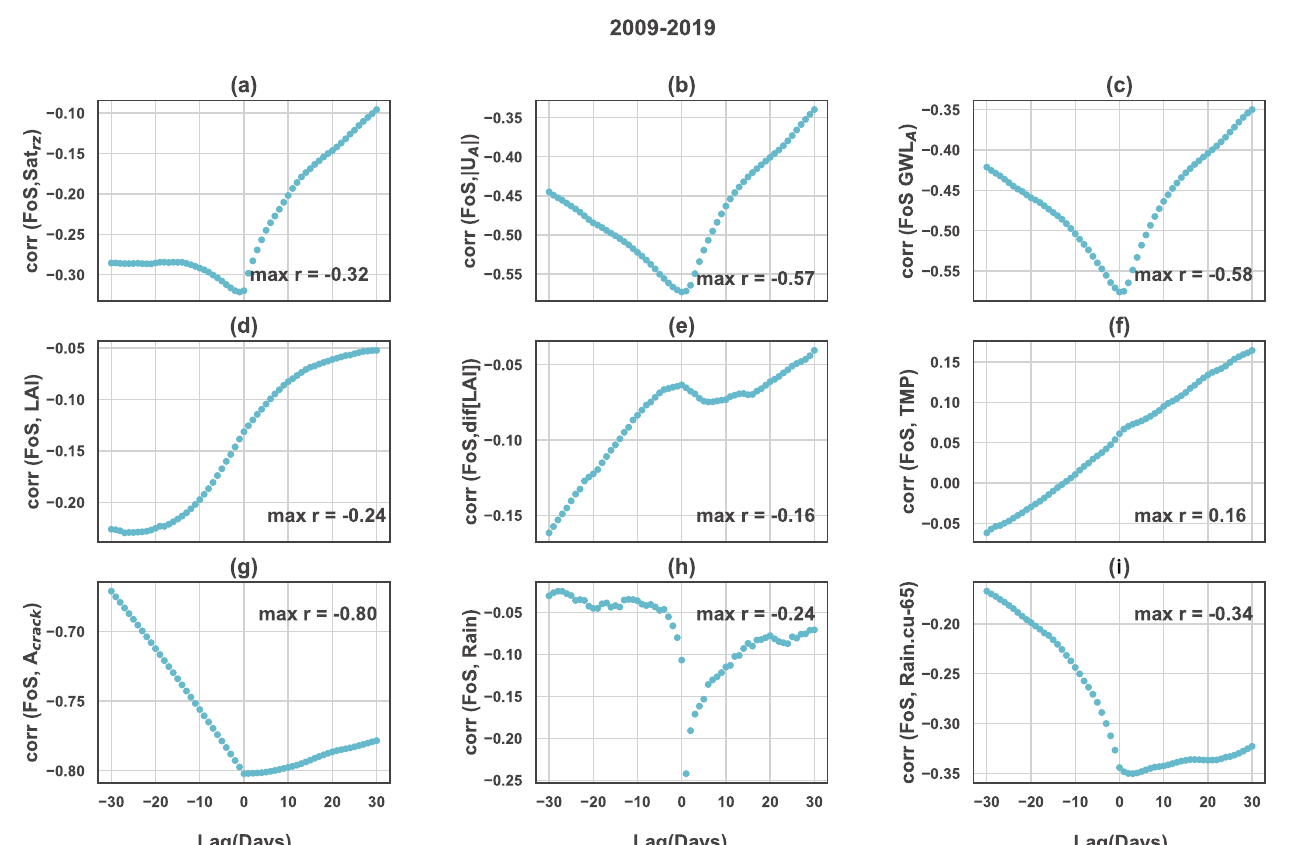
Figure 7. Lag correlation between FoS and ( a ) root zone saturation ( Sat rz ); ( b ) magnitude of total displacement ( | U A | ); ( c ) ground water level at point A ( GWL A ); ( d ) LAI ; ( e ) rate of LAI change over 15 days ( dif [ LAI ] ); ( f ) temperature ( TMP ); ( g ) crack area ( A crack ), ( h ) rain; ( i ) cumulative rainfall during the last 65